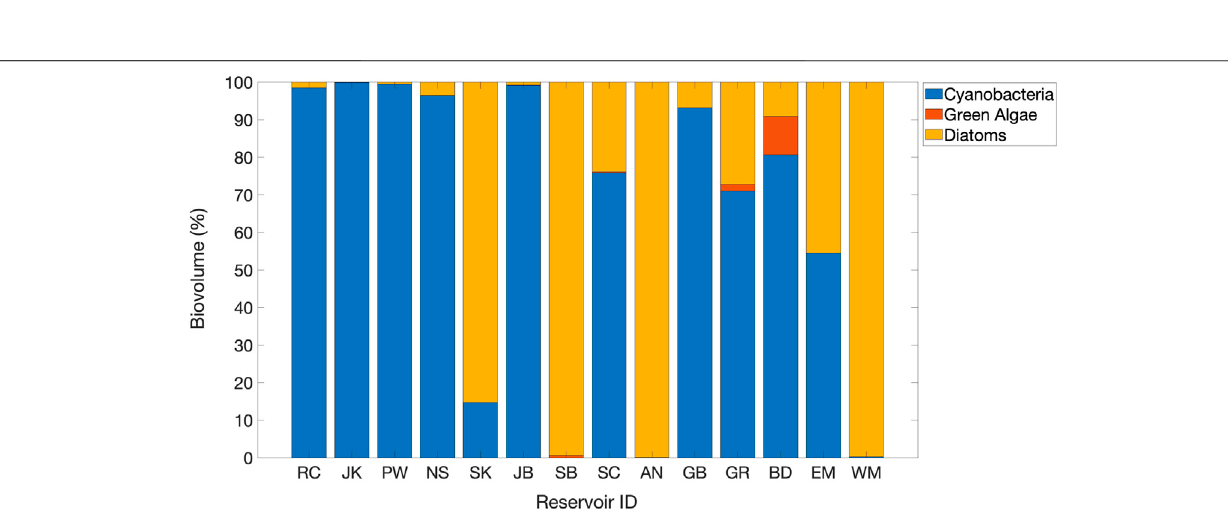
Frontiers in Environmental Science |